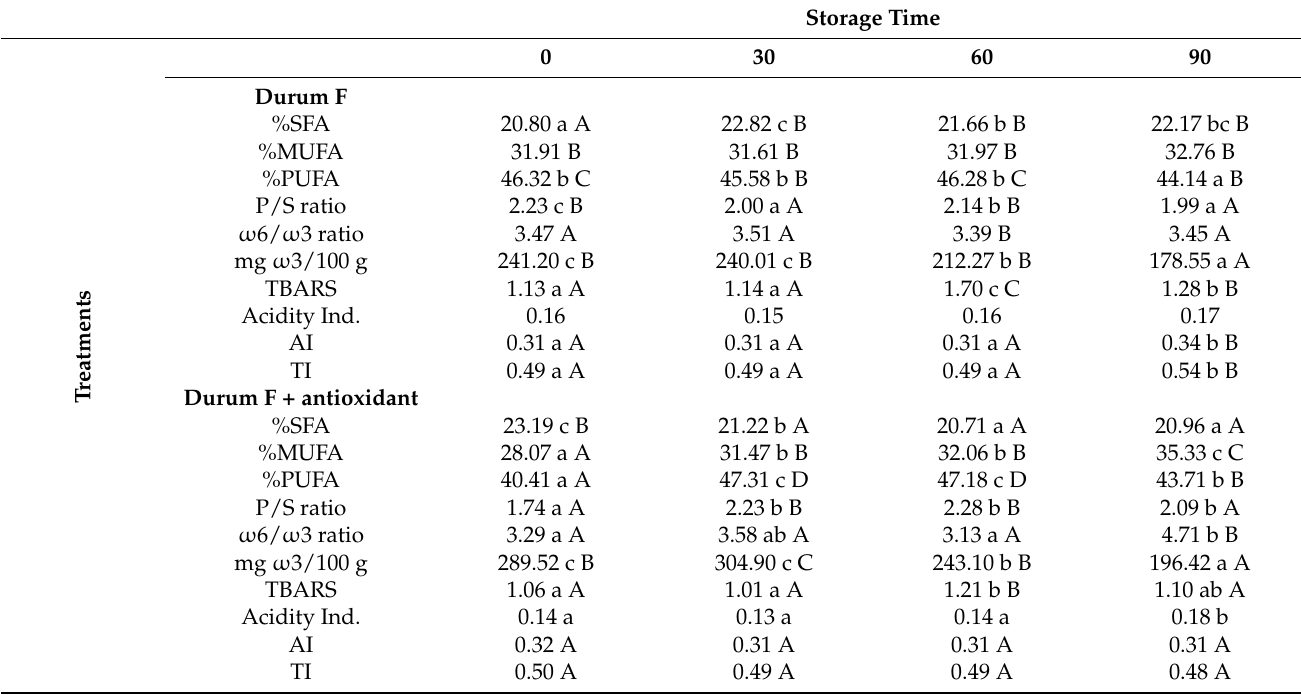
Table 4. Chemical indices and ratios for durum pasta.